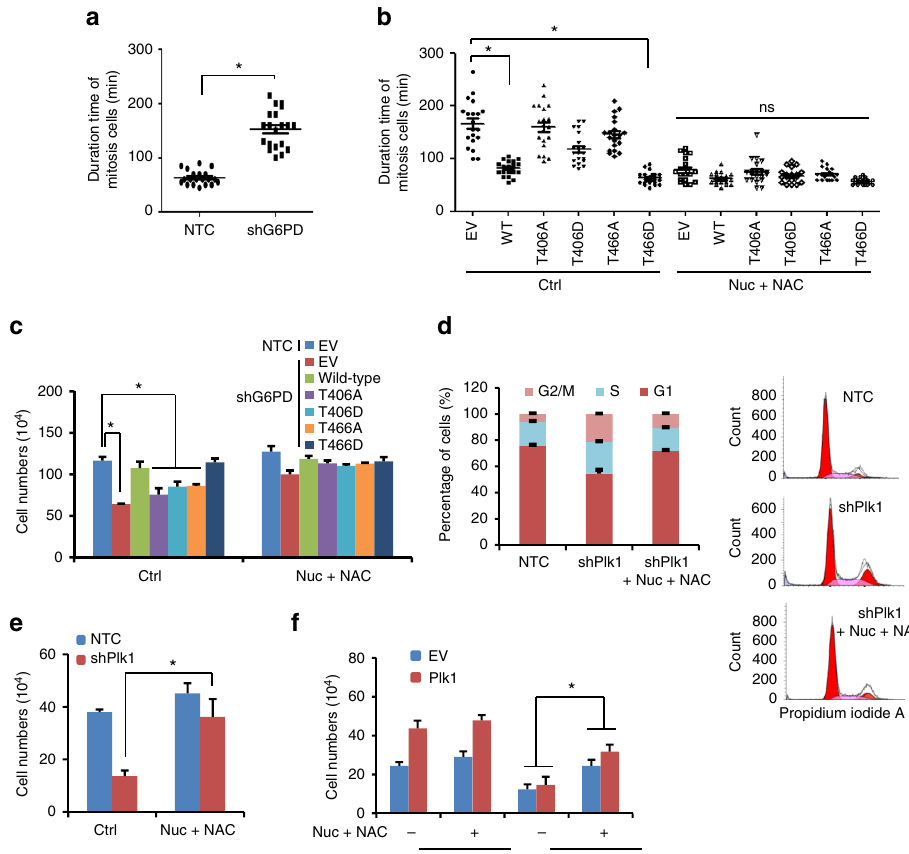
Fig. 6 G6PD activity is vital for Plk1-regulated cell proliferation. a HeLa cells stably transfected with tet-inducible NTC or shG6PD (expressing RFP) were subjected to the living cell imaging station. To induce shRNA expression, cells were grown in the presence of 0.1 μ g/ml doxycycline for 72 h. Then living cell imaging was done. The mitotic duration time of RFP positive cells was analyzed. n = 20 from 5 different fi elds. b HeLa cells stably expressing tet- inducible shG6PD (expressing RFP) were further transfected with vectors expressing eGFP-G6PD wild type and its mutants as indicated. Cells were treated with doxycycline in the presence or absence of NAC (2 mM) and Nuc mixtures (25 μ M) in the medium, followed by living cell imaging. Images were recorded for 48 h. The mitotic duration time of GFP and RFP double-positive cells was statistically calculated. n = 20 from 5 different fi elds. c HeLa cells stably expressing NTC or shG6PD were further infected with viruses expressing empty vector (EV) or Flag-G6PD wild type or its mutants as indicated. Cells were treated with vehicle or Nuc mix (25 μ M) and NAC (2 mM). Cell numbers were counted 4 days after treatment. Data were presented as mean